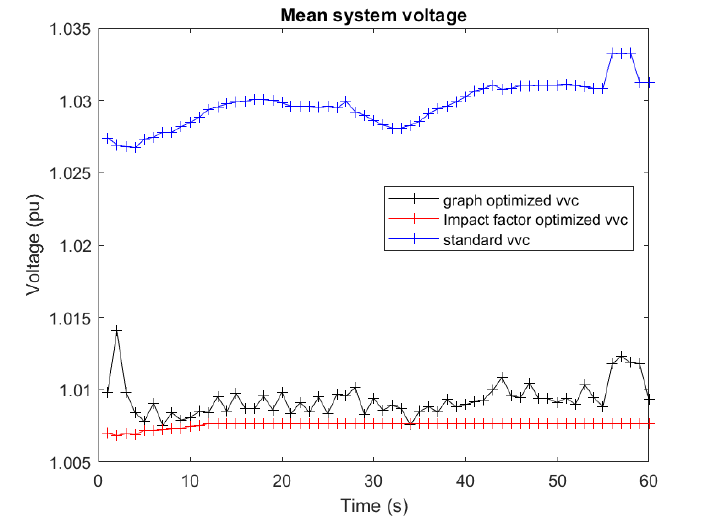
Figure 11. Comparison of voltage across the optimized one minute time